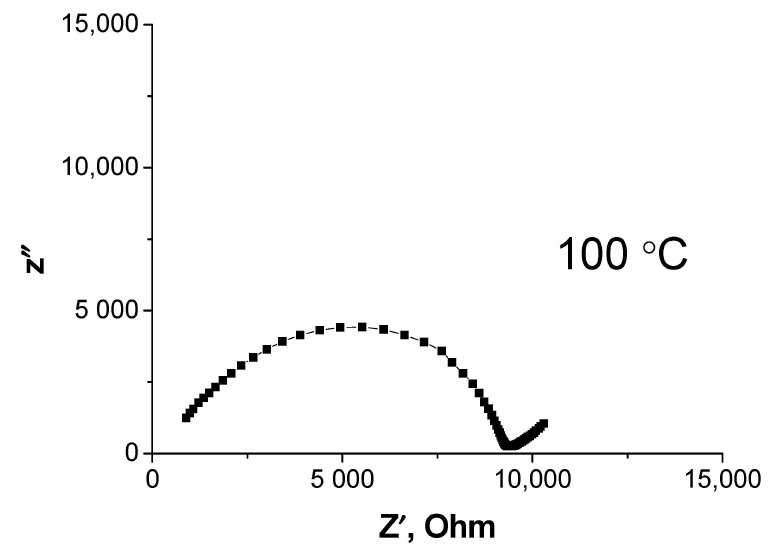
Figure 11. Impedance plot for Li|Li 3.8 Ge 0.9 S 0.1 O 4 |Li 1.3 V 3 O 8 cell at 100 ◦ C. Li|Li 3 . 8 Ge 0 . 9 S 0 . 1 O 4 |Li 1 . 3 V 3 O 8 cell is linear (Figure 12). However, its value is slightly lower The Arrhenius plot for the reciprocal of the internal specific resistance of Li|Li 3.8 Ge 0.9 S 0.1 O 4 |Li 1.3 V 3 O 8 cell is linear (Figure 12). However, its value is slightly lower compared to Li 3.8 Ge 0.9 S 0.1 O 4 due to the additional contribution of the contact resistance at the elec- trode|solid electrolyte interface. The effective activation energy is 53 kJ/mol, which is close to the value for the solid state electrolyte (50 kJ/mol).